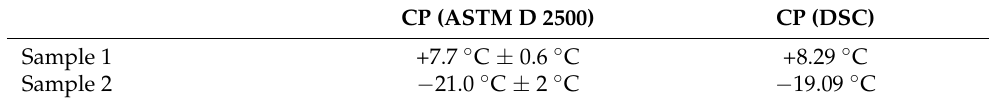
Table 2. Comparison of cloud point values obtained via ASTM and DSC